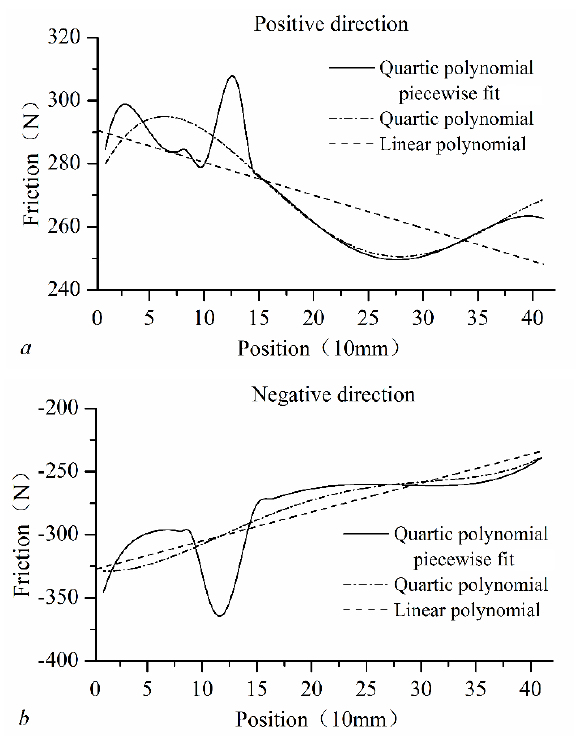
Figure 7. IAFVs obtained using linear, quartic, and piecewise polynomial fits. ( a ) Position direction; ( b ) Negative direction.